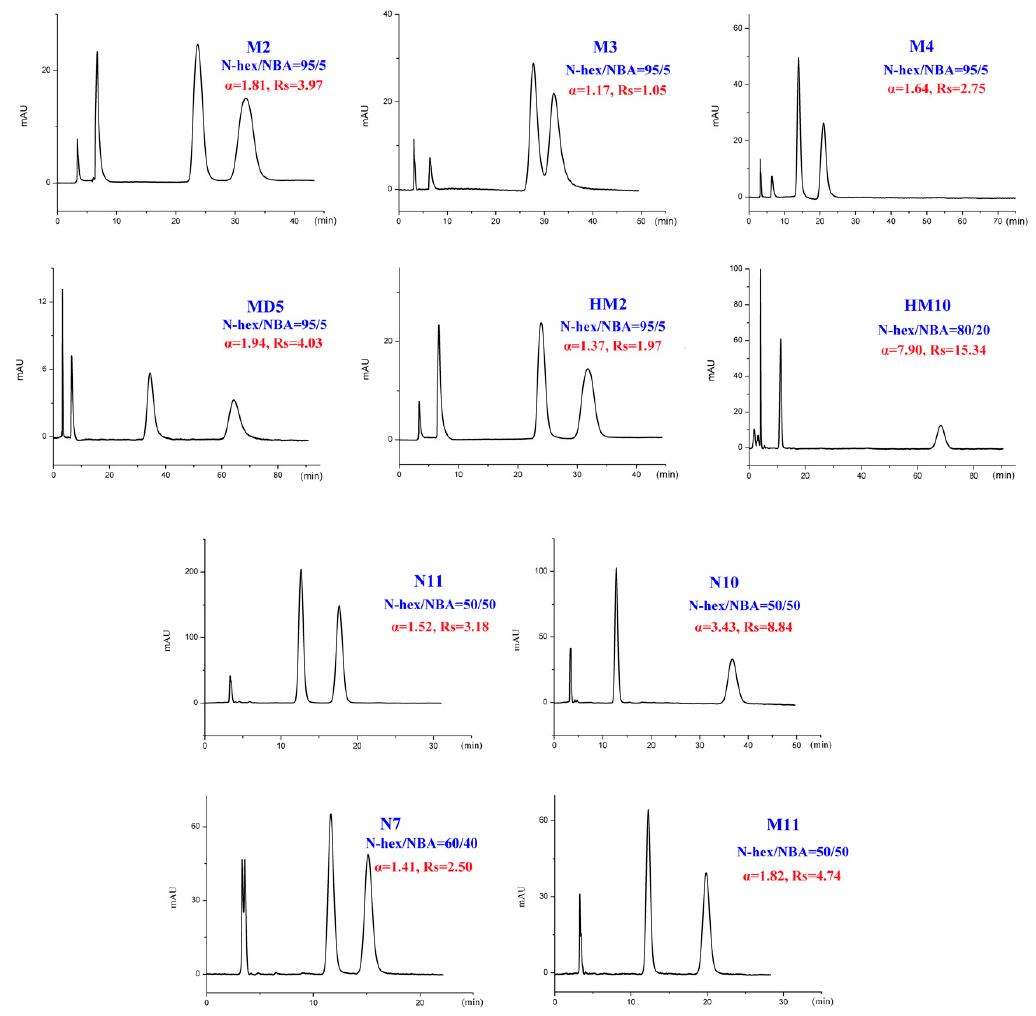
Figure 5. Typical chromatograms with n-butanol (NBA) as organic modifier under normal-phase mode.